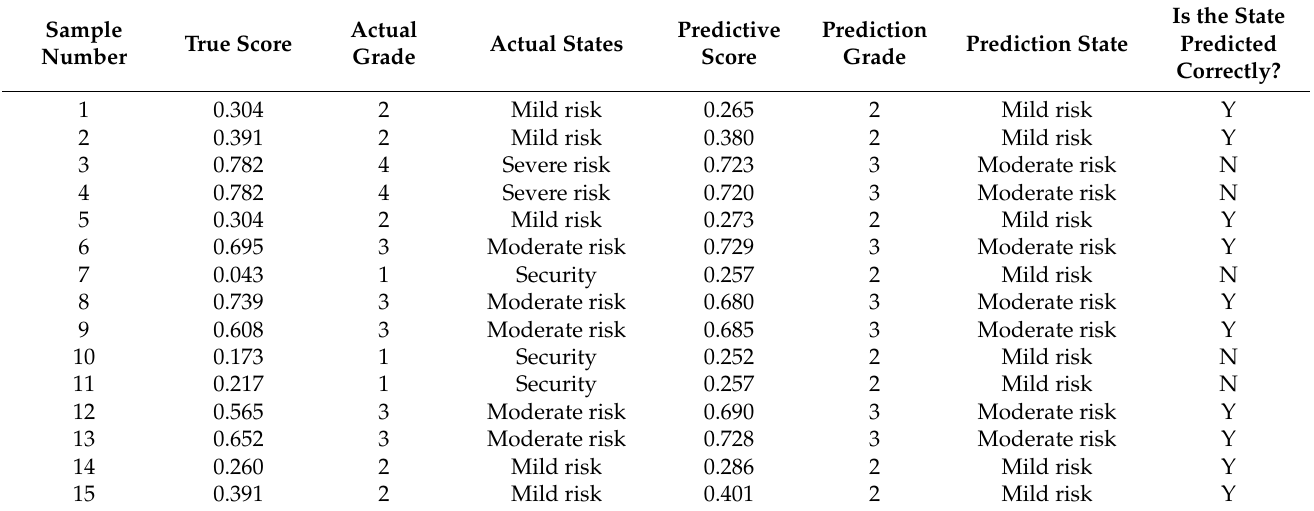
Figure 4. The variation in mean square error. Table 11. Results of model